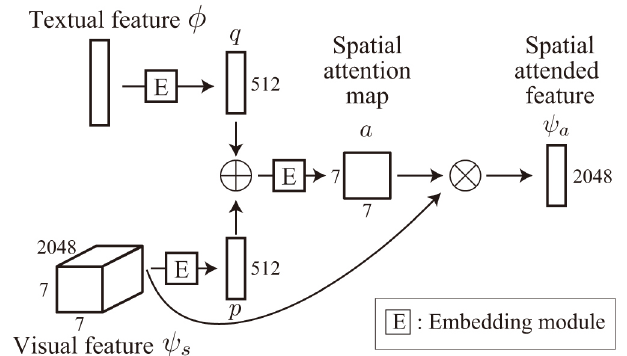
Figure 2. The spatial attention mechanism used in the sequential visual network.